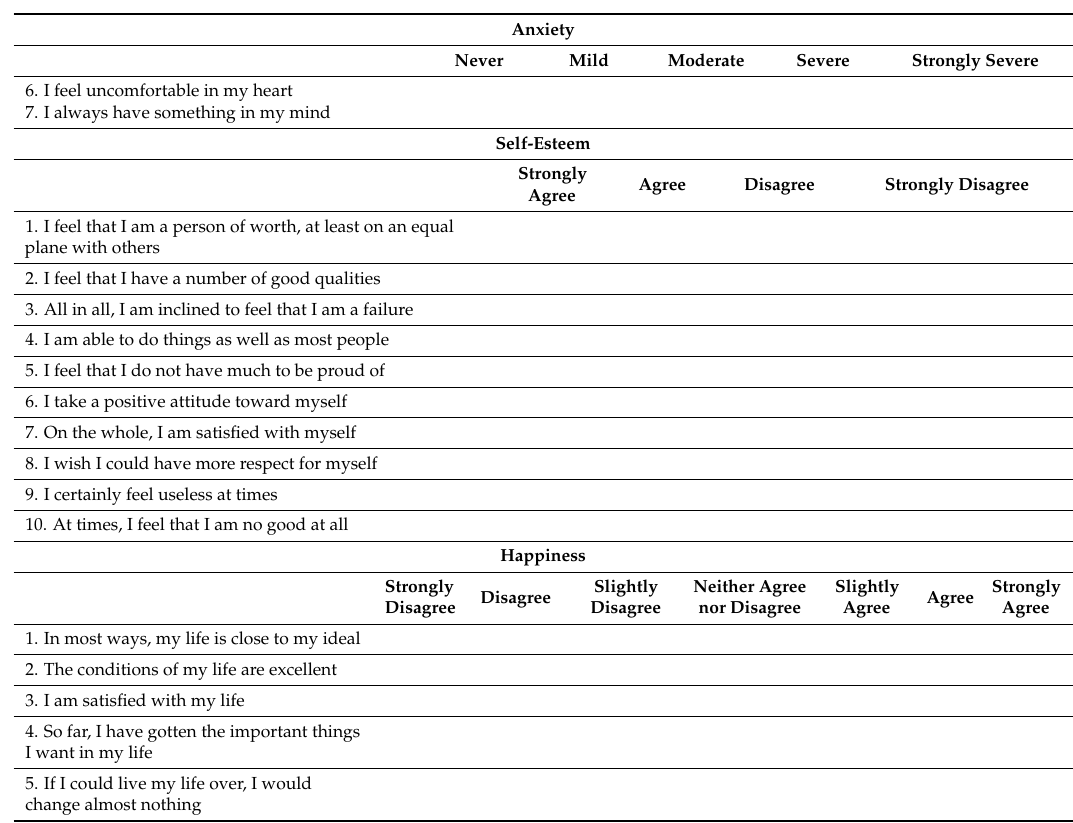
Table A2. Mental health